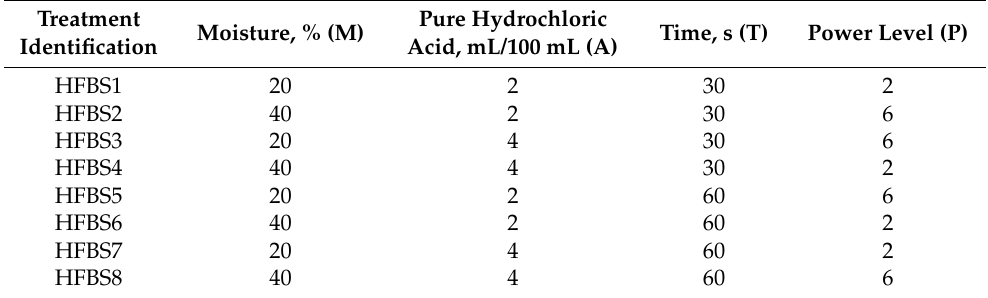
Table 4. The 2 4 − 1 fractional factorial design to explore starch acid hydrolysis by microwave energy.